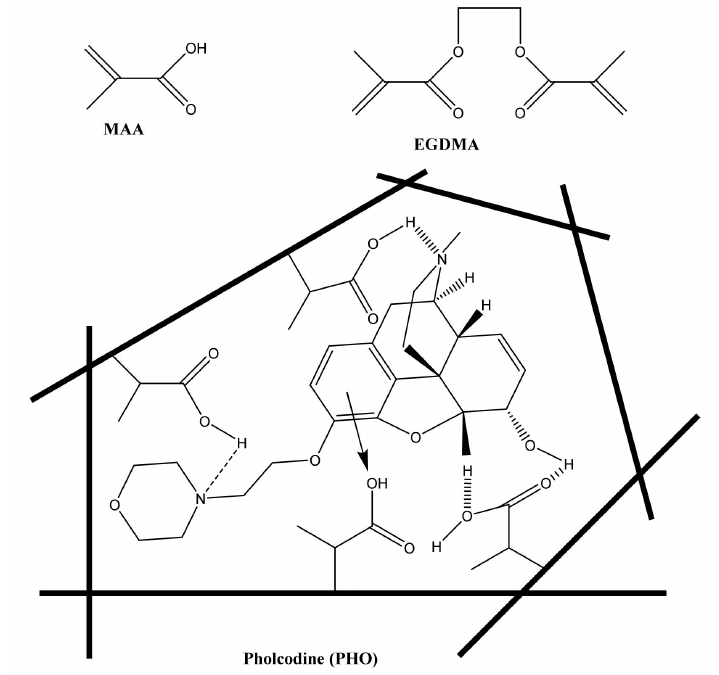
Figure 1. A schematic representation for the imprinting process of